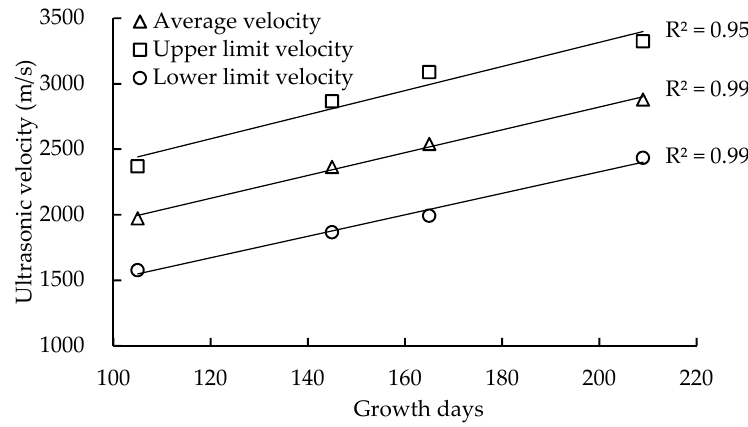
Figure 8. Relationship between ultrasonic velocity and growth days.